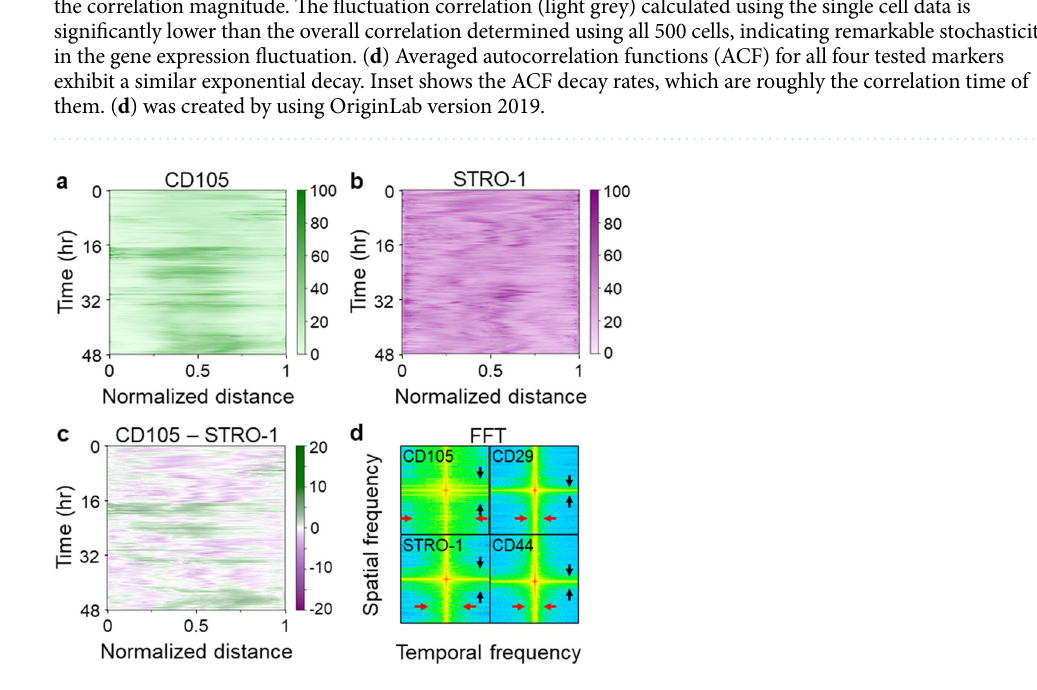
Figure 5. Prediction of temporal marker expression holds information on intracellular heterogeneity. ( a , b ) Heatmaps showing intracellular marker distribution and fluctuation for typical MSC surface markers. Fluctuation patterns vary significantly between tested markers indicating strong marker dependency within a single cell. ( c ) Protein localization differences of CD105 and STRO-1 underlining marker dependency. ( d ) 2D Fast Fourier Transform of heatmaps ( a , b ) revealing oscillatory frequency differences in time and space. Red and black arrows highlighting characteristic temporal and spatial fluctuation lengths, respectively. CD105 shows highest temporal and spatial fluctuation. Subfigures were generated using the OriginLab software version 2019 ( a – c ) and Fiji ImageJ 79 software ( d